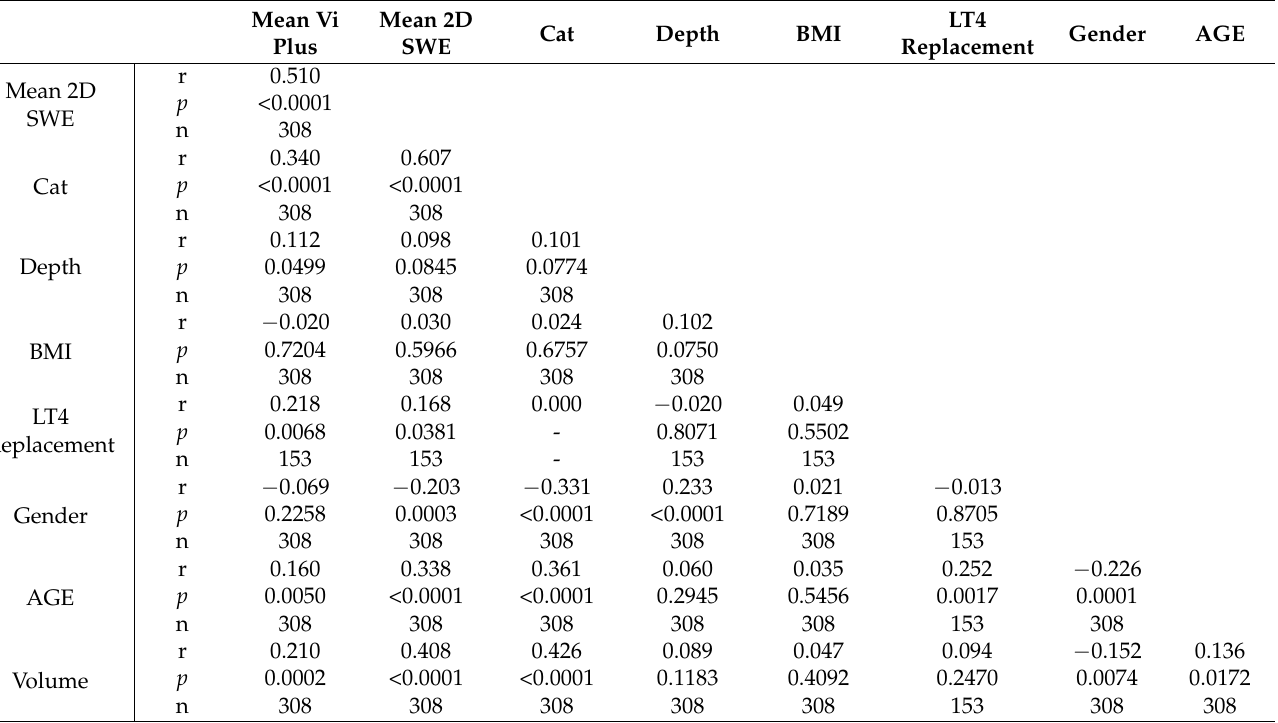
Table 4. Correlation table using Pearson correlation